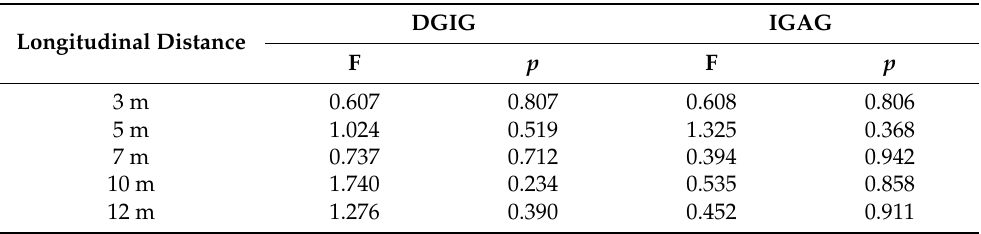
Table 3. Values of the lateral apoapsis corresponding to different glare perceptions at different lon- gitudinal distances. Longitudinal Distance (m)